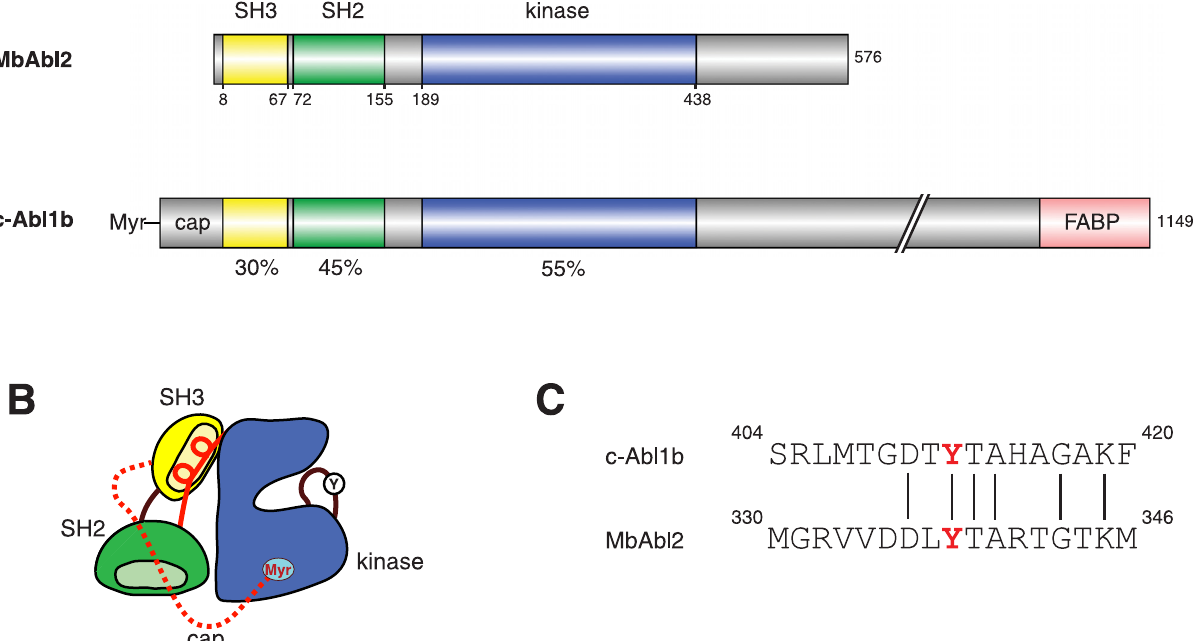
Fig 1. Domain organization of MbAbl2. (A) A schematic diagram showing the domain organization of MbAbl2 and mammalian Abl (murine c-Abl, 1b isoform). The percent amino acid identity for each domain is shown below the figure. (B) Cartoon representing the autoinhibited structure of mammalian Abl. The SH3 domain is in yellow, the SH2 domain is green, and the kinase domain is blue. The N-terminal myristoyl group (Myr) binds in a pocket on the kinase domain. The cap sequence is shown by a dashed red line, and the intramolecular SH3 ligand is shown by a solid red line. Tyrosine 412 (Y) in the activation loop is pictured. (C) Sequence comparison at the autophosphorylation site within the kinase activation loop.